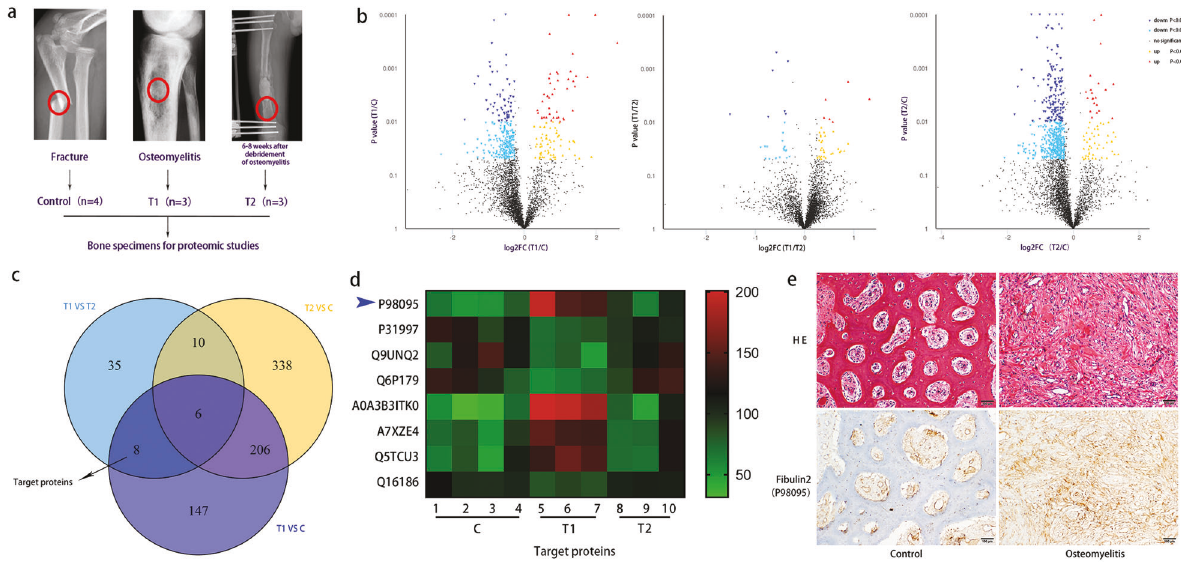
Fig. 1 Fibulin2 is highly expressed in infected bone tissues of patients with osteomyelitis. a Schematic diagram showing the bone tissue subjected to proteomic analyses. Bone samples were collected from the areas indicated by the red rings. b Volcano plots presenting the differentially expressed proteins identi fi ed through comparisons between two groups. c Venn diagram showing the signi fi cant differences in 8 target proteins in the osteomyelitis and normal control samples and in the osteomyelitis samples before and 6 – 8 weeks after debridement. d Heatmap showing 8 target proteins. P98095 (blue arrow) was selected for further research. e HE and Fibulin2 (P98095) staining of normal and infected bone. HE staining showed obvious in fl ammatory cell in fi ltration and bone destruction in the sections with osteomyelitis. Moreover, locally enhanced Fibulin2 expression was captured in approximately the same infected